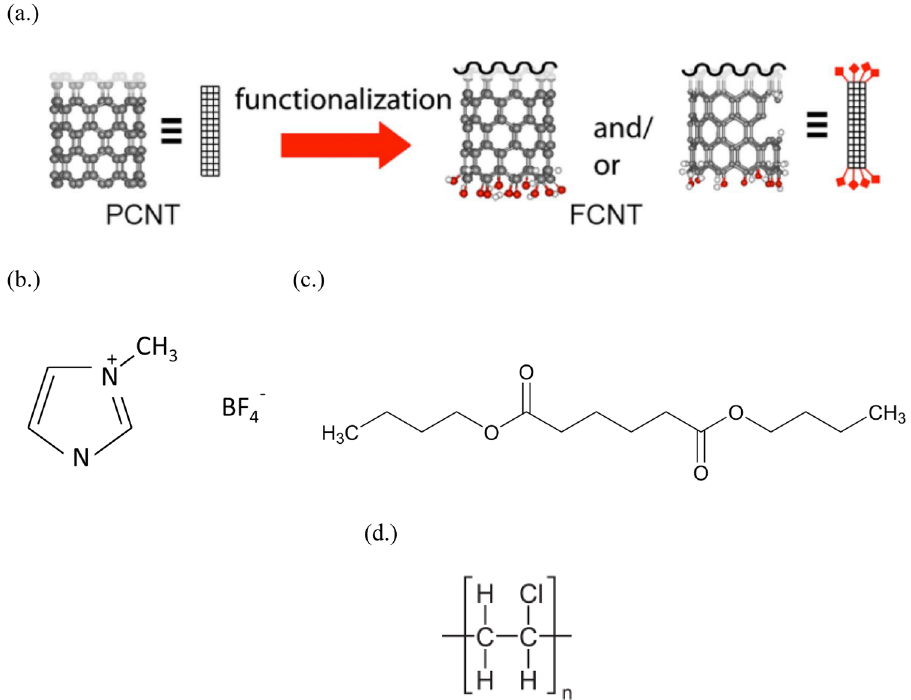
Figure 1. ( a ) Schematic illustration of functionalization process of carbon nanotubes; black, red, and white balls represent carbon, oxygen, and hydrogen, respectively. Image reused from 25 with CC general permission.